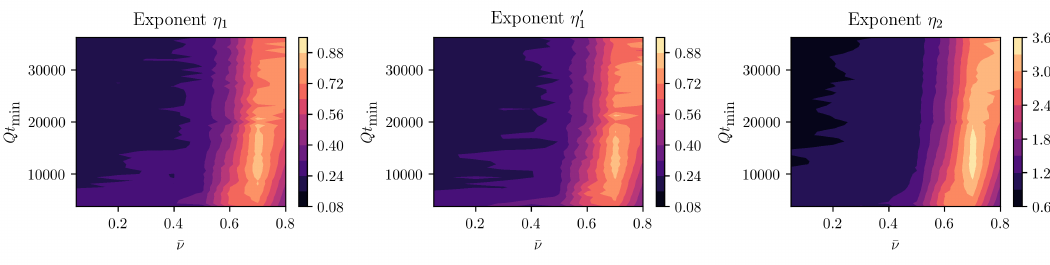
Figure 8: Persistent homology scaling exponents for different filtration parameters ¯ ν and minimum fitting times Qt min